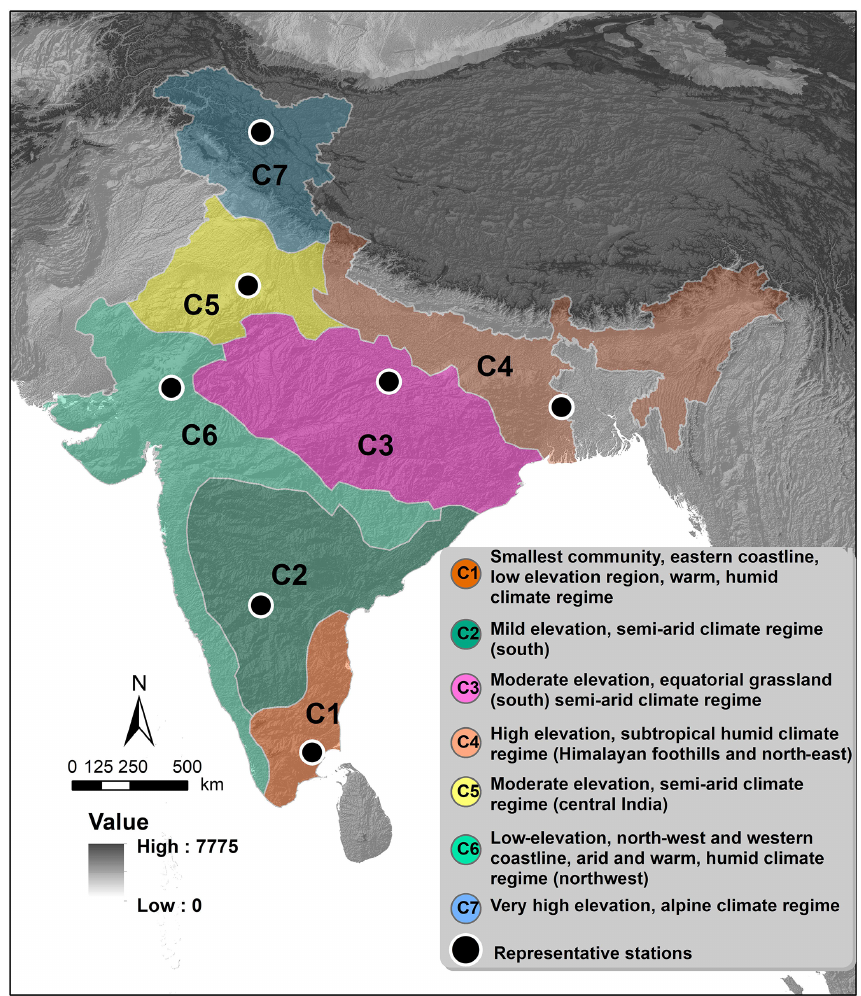
Figure 4. Spatial distribution/extent of the seven regions, or communities, with similar heavy precipitation event characteristics across India. Black dots indicate the representative grid cells for each of the community identified using the Z − P space approach. Terrain characteristics of the Indian subcontinent are shown using the SRTM DEM (in the